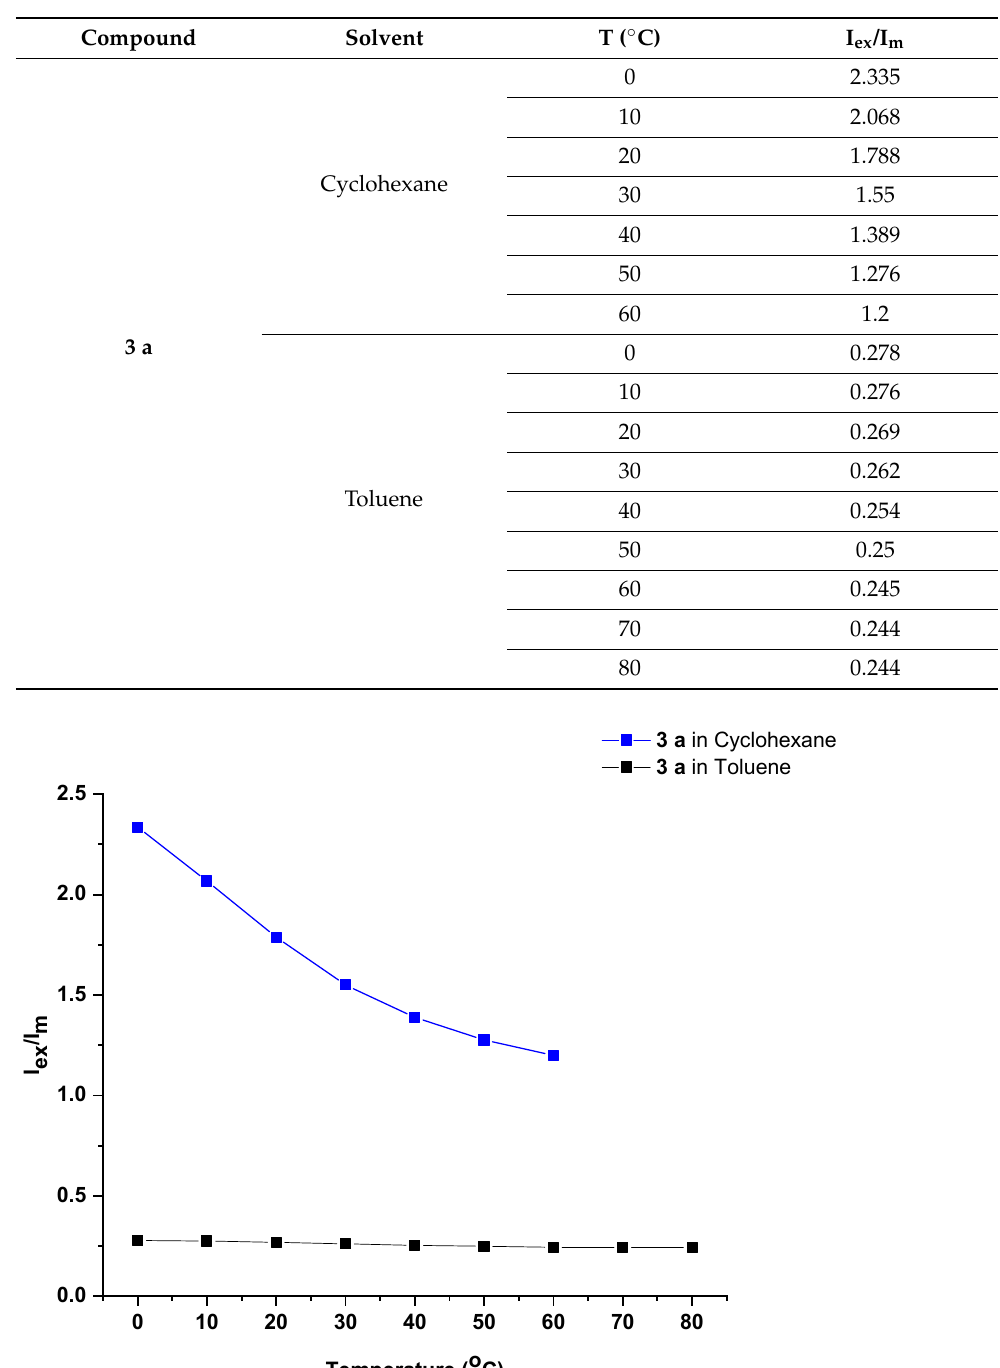
Table 3. I ex /I m ratio in cyclohexane and toluene solutions of polymer 3 a at different temperatures.